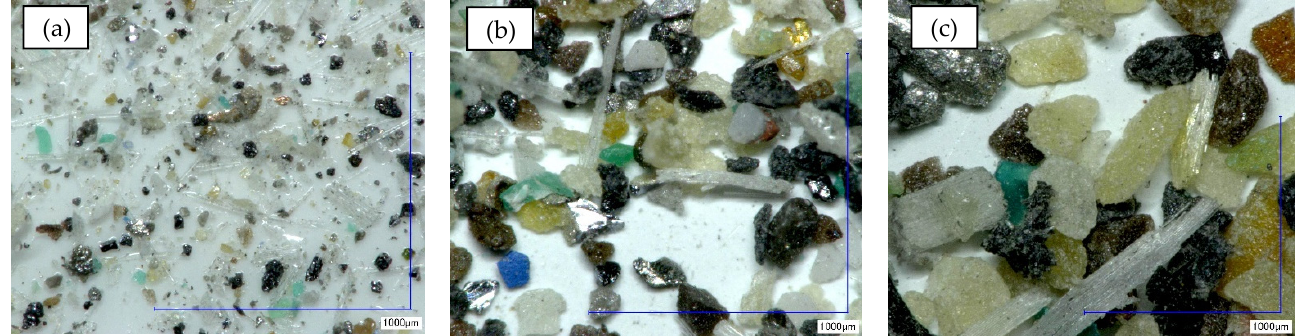
Figure 4. Optical images at magnification ×200 times, of disintegrator-crushed PCBs fractions: ( a ) is d < 90 µm; ( b ) is d = 90–180 µm; and ( c ) is d = 180–350 µm and designated [A], [B] and [C], respectively.